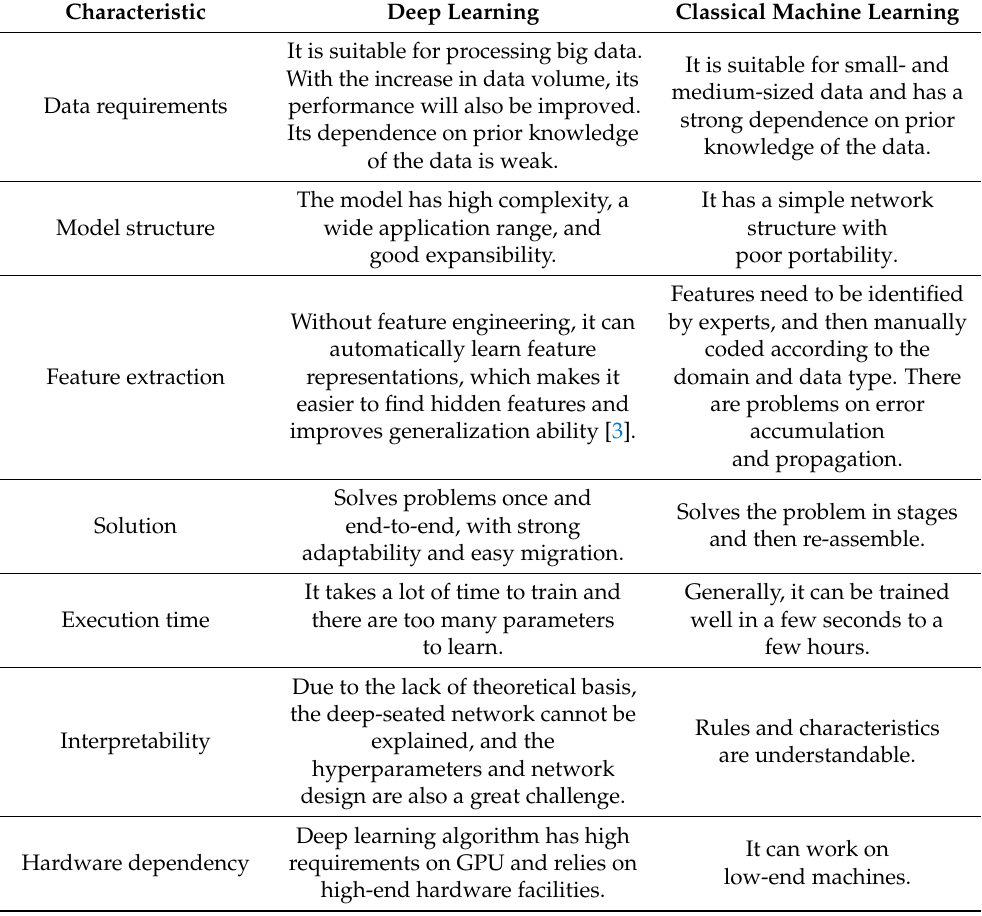
Table 2. Differences between deep learning and classical machine